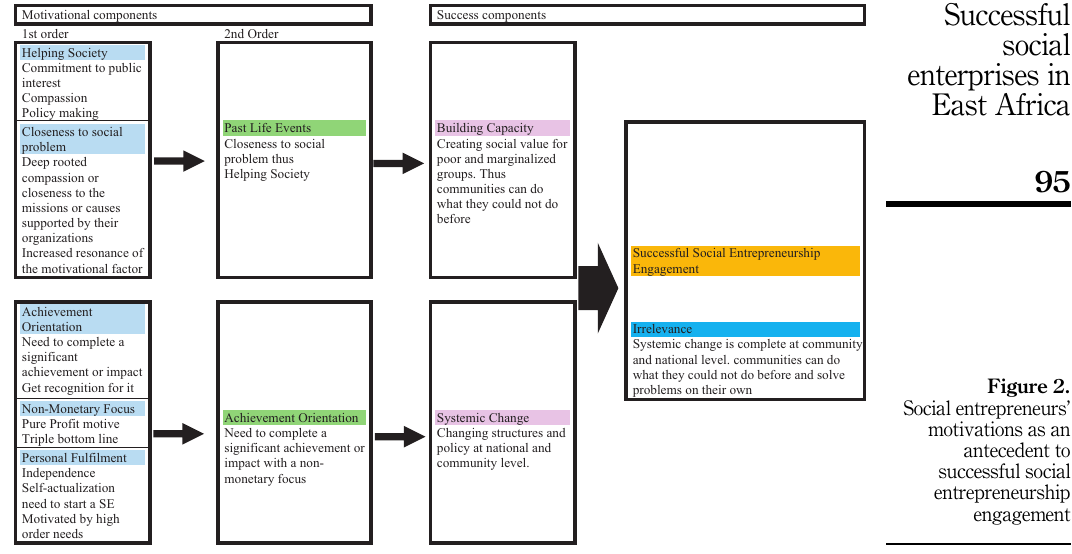
Figure 2. Social entrepreneurs